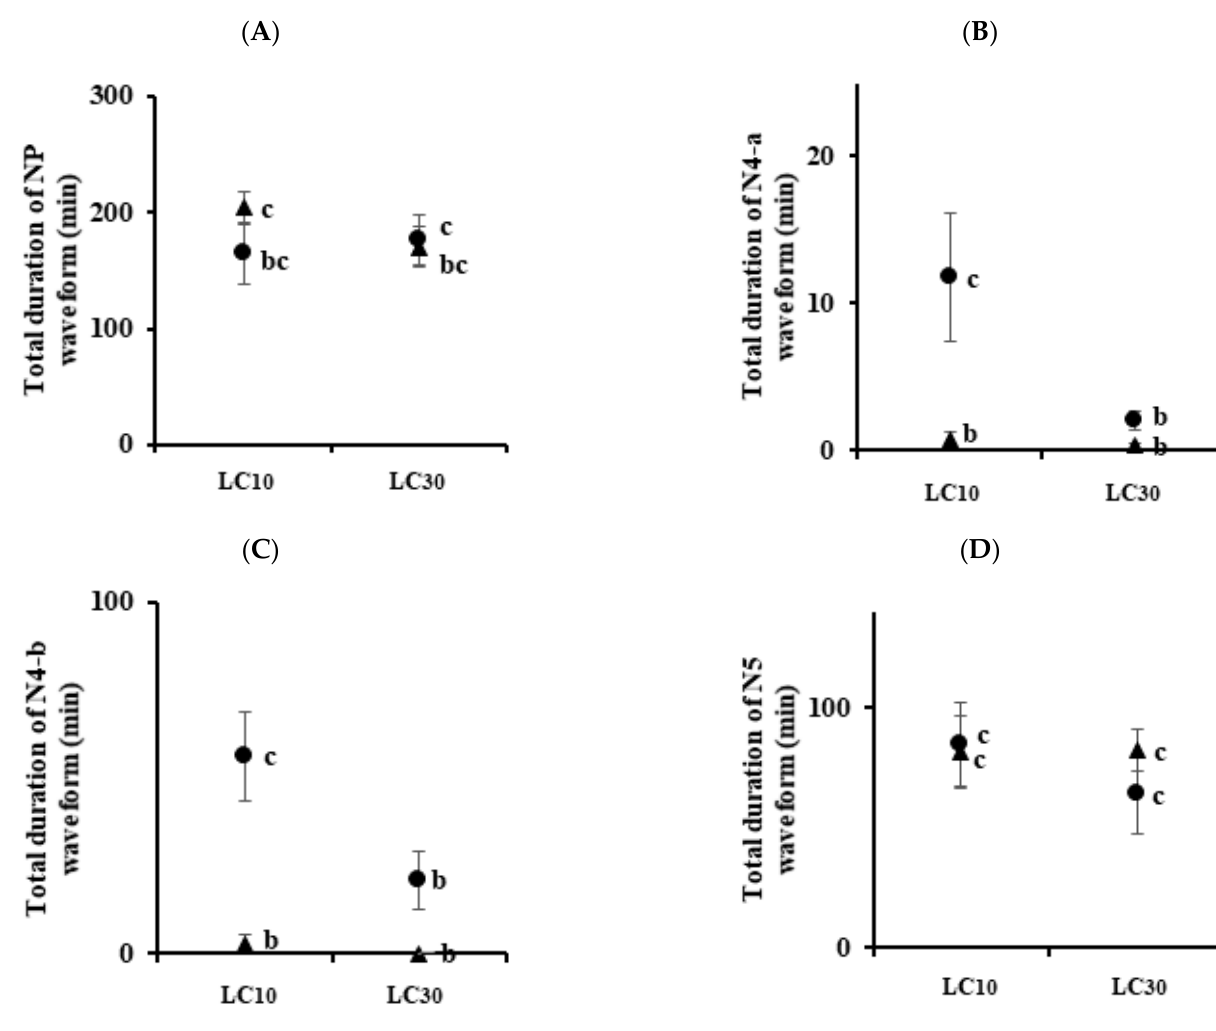
Figure 4. Total duration for each waveform of N. lugens and S. furcifera treated with LC 10 and LC 30 concentrations of imidacloprid. Panel ( A ) is the duration of the NP waveform, panel ( B ) is the N4-a waveform, panel ( C ) is the N4-b waveform, and panel ( D ) is the N5 waveform. Circles are Nilaparvata lugens and triangles are Sogatella furcifera . Means followed by the same letters are not significantly different ( p = 0.05; Tukey’s studentized range test (SAS Institute 9.0 (SAS, 2009)). Error bars indicate ± SE.